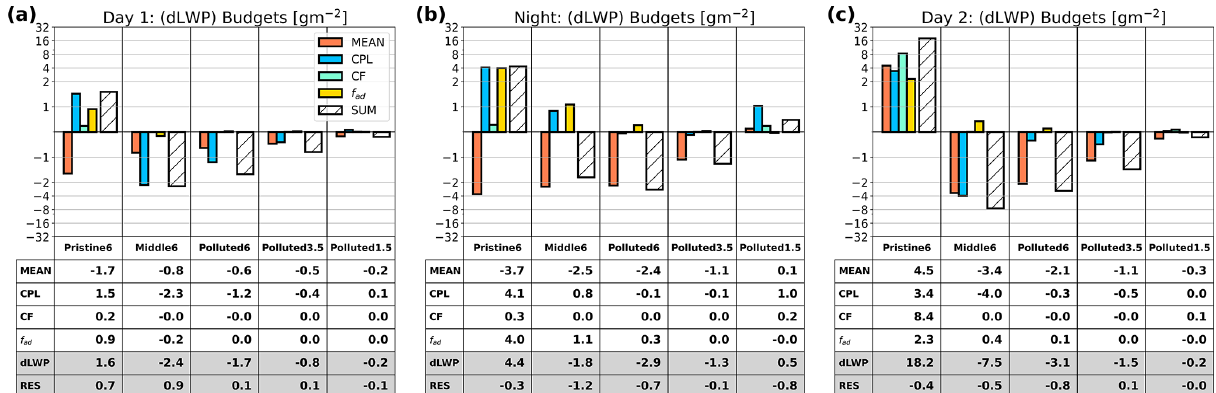
Figure 8. The dLWP budgets for (a) Day 1, (b) Night, and (c) Day 2. The histograms show the dLWP induced by changes in the MBL mean state (orange) and coupling state (blue), the dLWP induced by changes in the CF (green) and f ad (yellow), and the sum of all budget terms (SUM, hatched). The tables below the histograms show the values given in the plots as well as the residual between the actual dLWP and that estimated using the approach shown in Appendix. A. Note the logarithmic y -axis